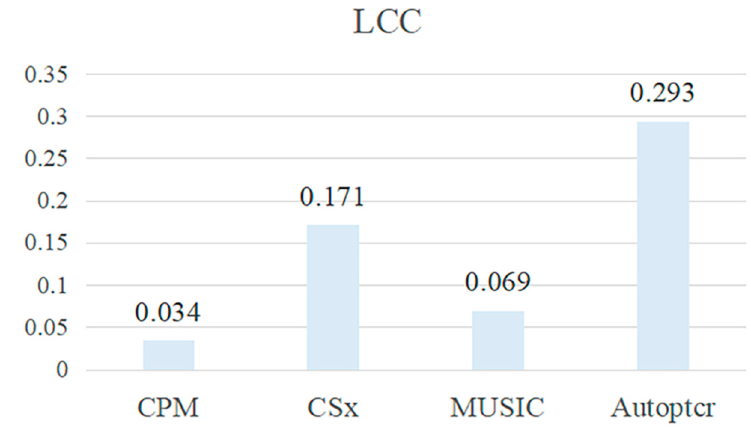
Figure 8. LCC of CPM, CSx, MusiC, and Autoptcr on PBMC2.